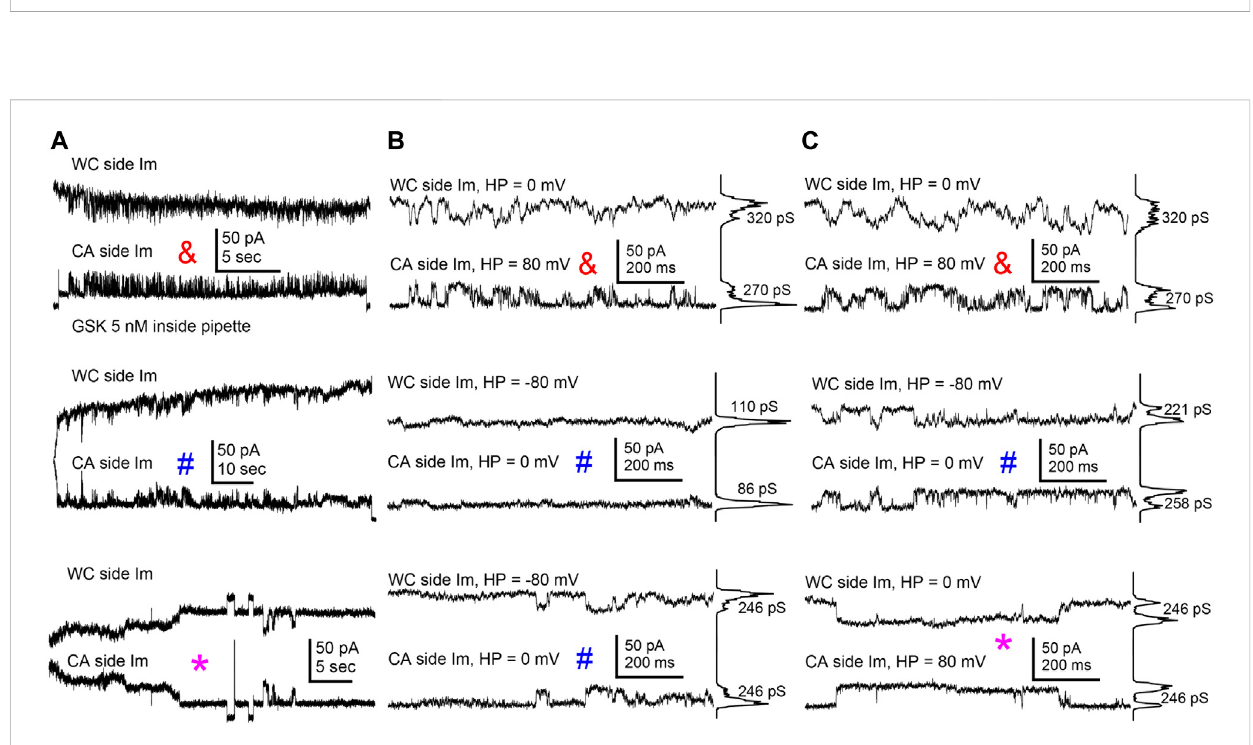
FIGURE 8 TRPV4 agonist GSK1016790A induced channel activity consistent with Cx43 HCh. (A) Long stretches of channel activity on the attachedmembrane patch recorded with the WC/CA combined con fi guration before (&) and after (# and * ) the GSK1016790A-induced transient gm increase shown in previous fi gure(symbolandcolorcoded asinFigure 7). (B – C) Expandedsegmentsfrom thetracesonA showedmirroredchanneltransitions compatible with Cx43 HCh. All-points histograms at the right of the shorter stretches indicate the most apparent transition conductance values. Transitions smaller than 100 pS (traces at the center of fi gure), compatible with reported amplitude of TRPV4 channels, were also